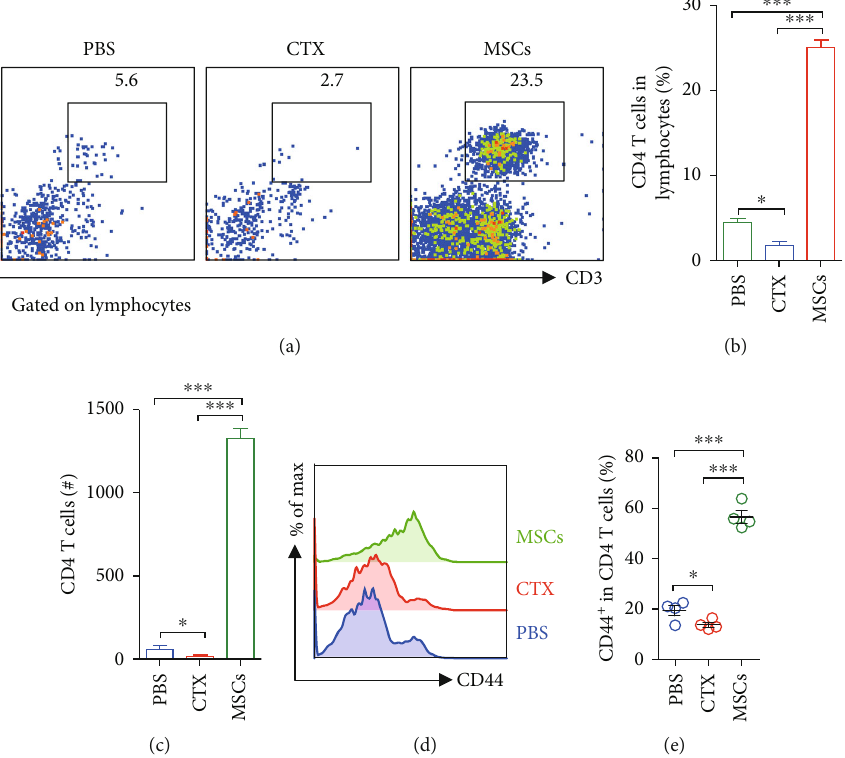
Figure 3: Treatment with MSCs signi fi cantly increased CD4 T cells in the lung. Mice were treated with MSCs or CTX as described above. BALF cells were collected and analysed by surface staining. (a) Representative FACS data of BALF CD4 T cells. The frequencies (b) and absolute numbers (c) of CD4 T cells. (d, e) Expression of CD44 by CD4 T cells. Data were expressed as the means ± SEM . n = 3 -4 mice for each treatment group; ∗ p < 0 : 05 and ∗∗∗ p < 0 : 001 . This experiment is representative of three individual